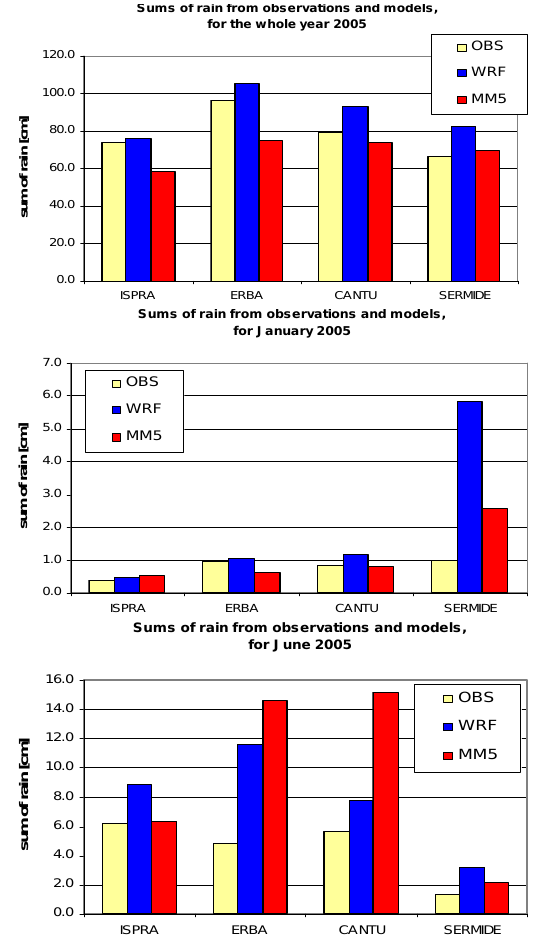
Fig. 2b. The quantities of rain observed and predicted by the mod- els, respectively from top to bottom: for the whole of the year 2005, for January and for